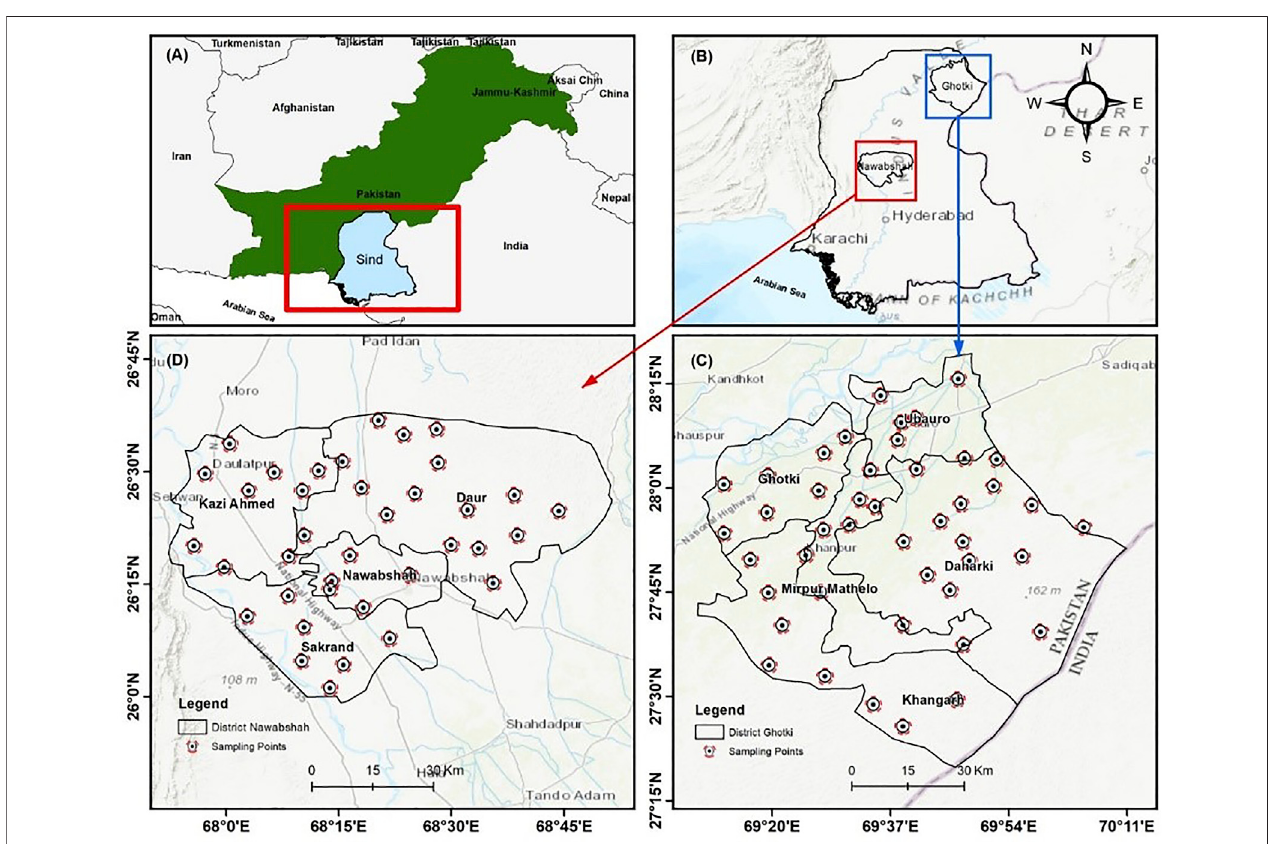
FIGURE 1 | Groundwater sampling points in the study area of the (C) Ghotki and (D) Nawab Shah districts, in Sindh Province (B) , Pakistan.